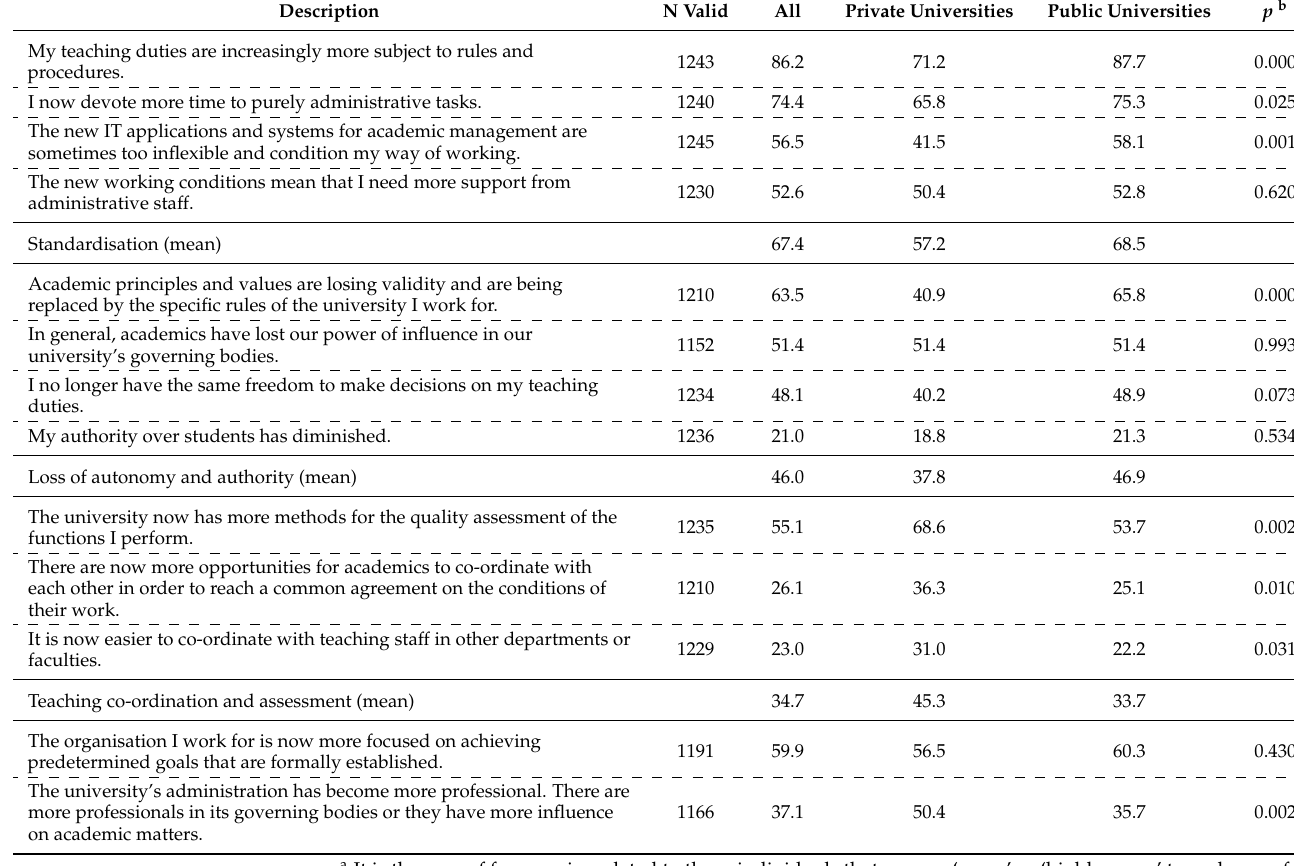
Table 3. Relative frequency (in %) of individuals who agree with each item a